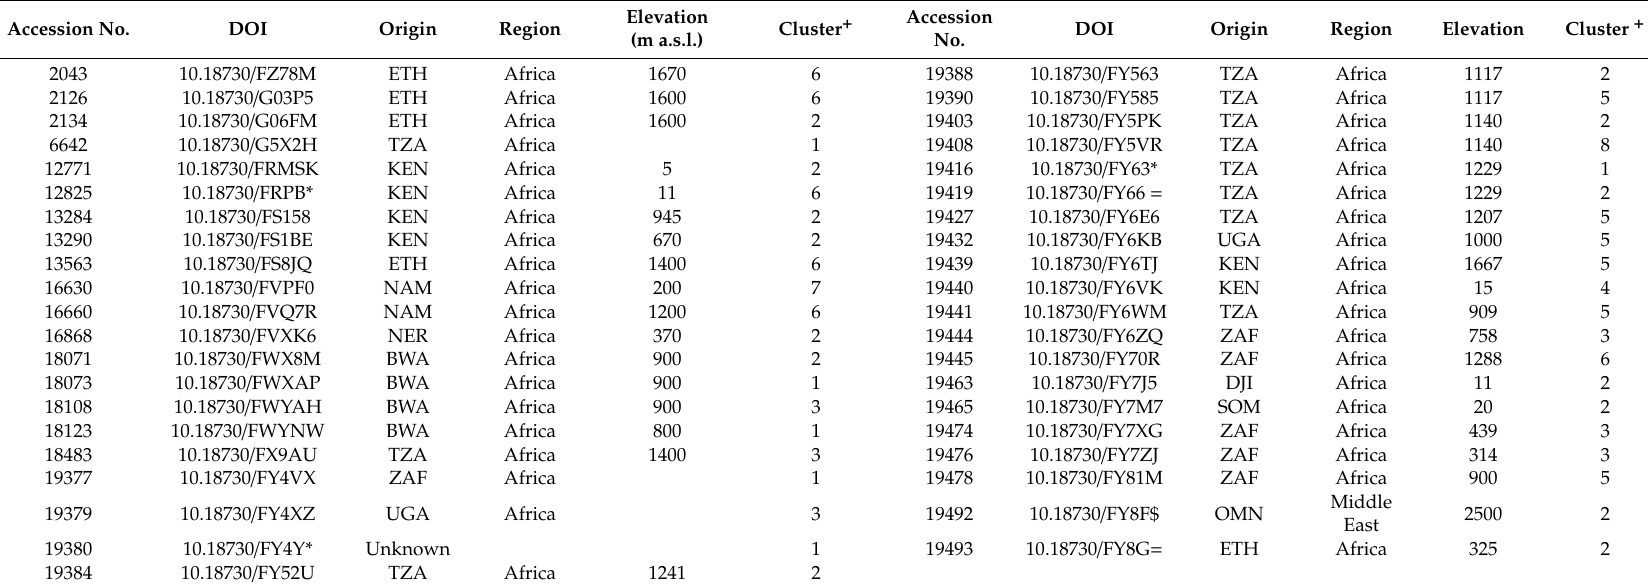
Table 2. List of accessions, origin, and cluster groups constituting the core collection based on genotyping data. Accession No.